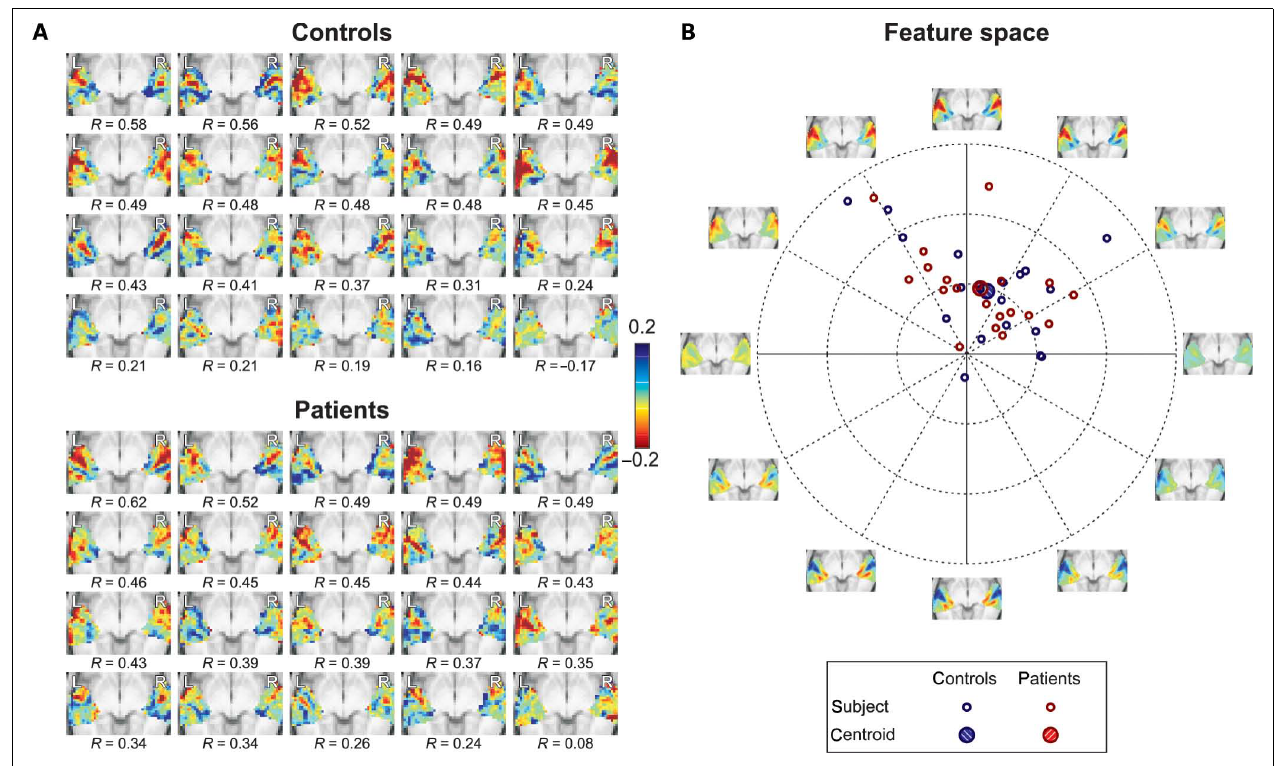
Each subject is represented by a colored symbol at coordinates that reflect the loading on the two features.The axes are labeled with images that display the spatial response maps corresponding with the dimensions of the feature space, as are various mixtures along diagonals in between.The further from the origin, the more pronounced a feature is represented in a